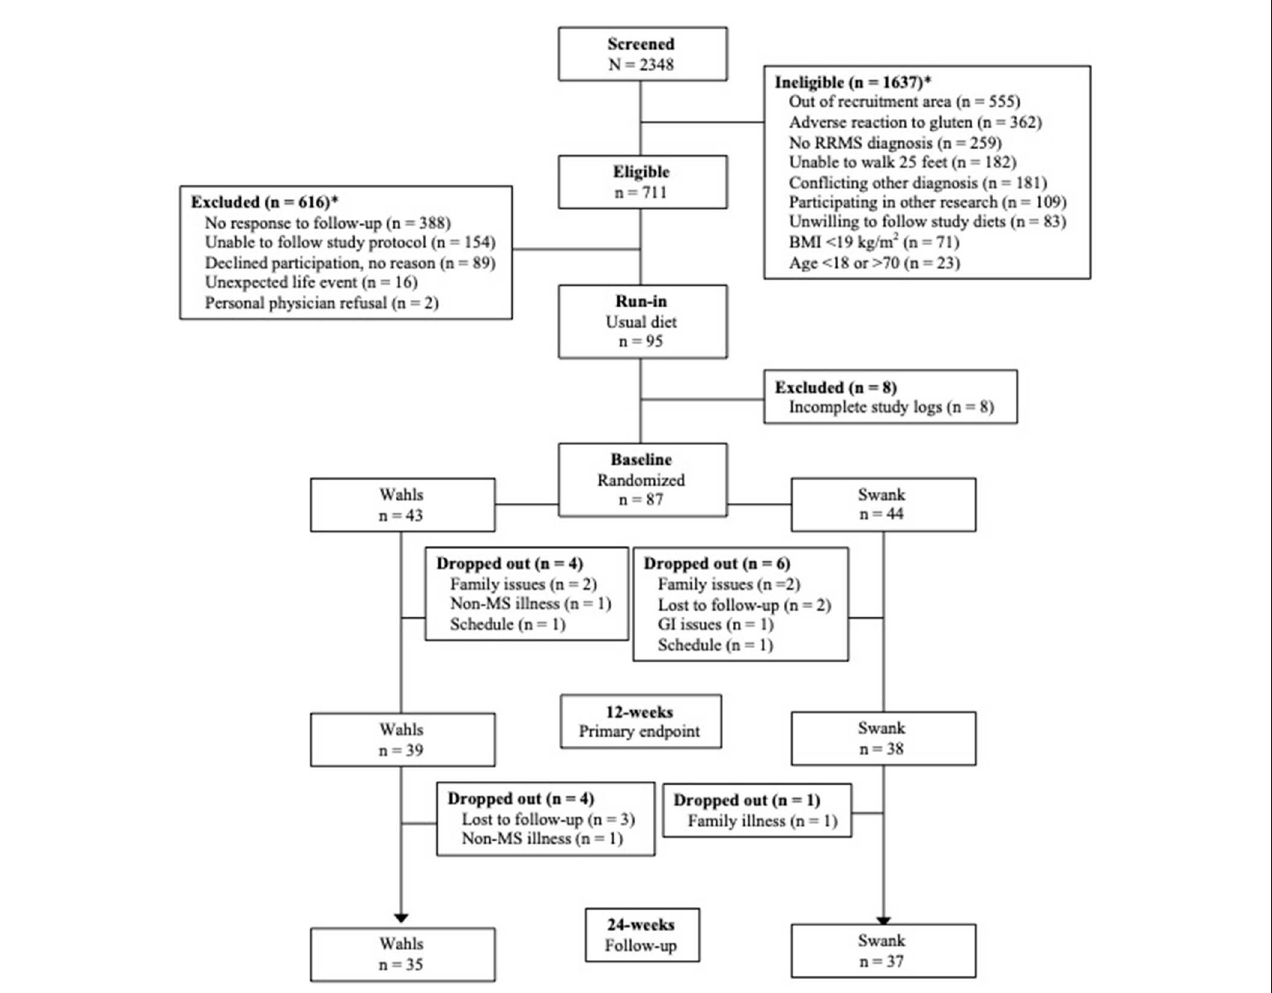
FIGURE1 CONSORT diagram of study recruitment and participant flow. *Reasons for ineligibility or exclusion may not add up to the total of ineligible or excluded because some participants were found ineligible or were excluded for multiple reasons. Adapted from Wahls et al.